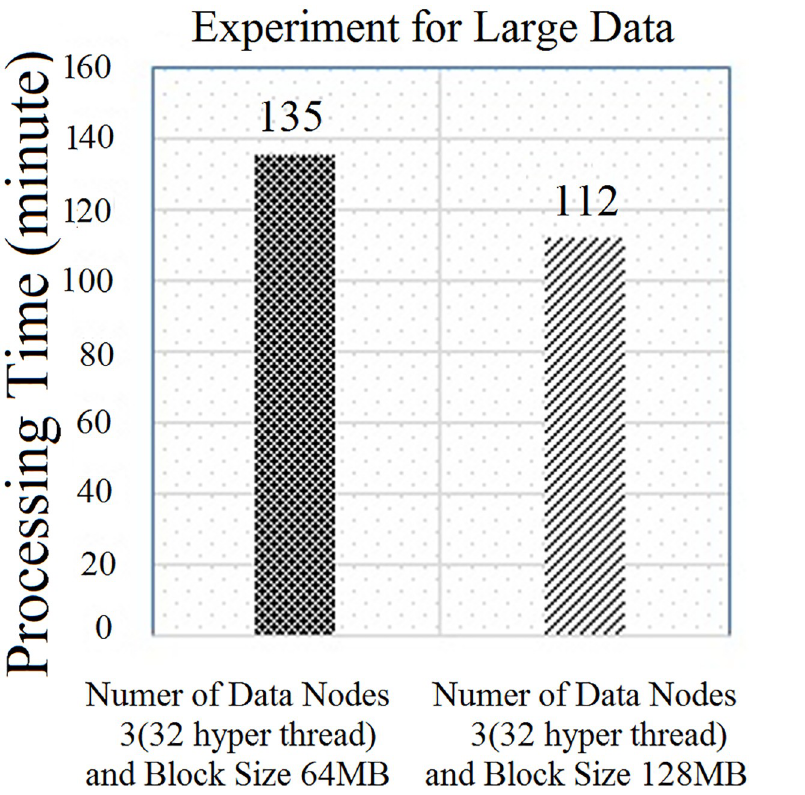
Fig 13. Comparison of Hadoop processing time on large data with different block sizes.